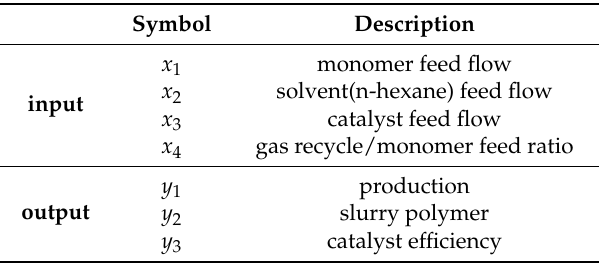
Table 1. The description of input and output